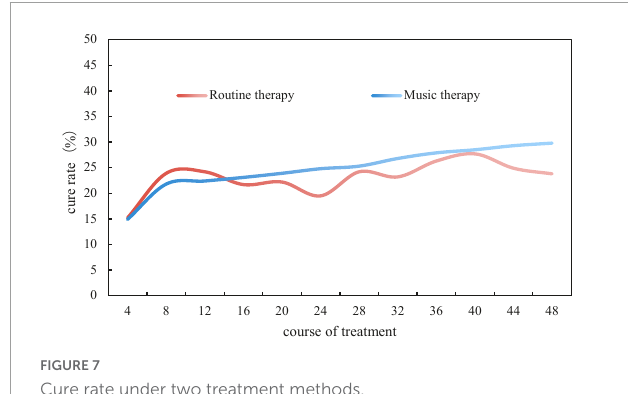
FIGURE7 Cure rate under two treatment